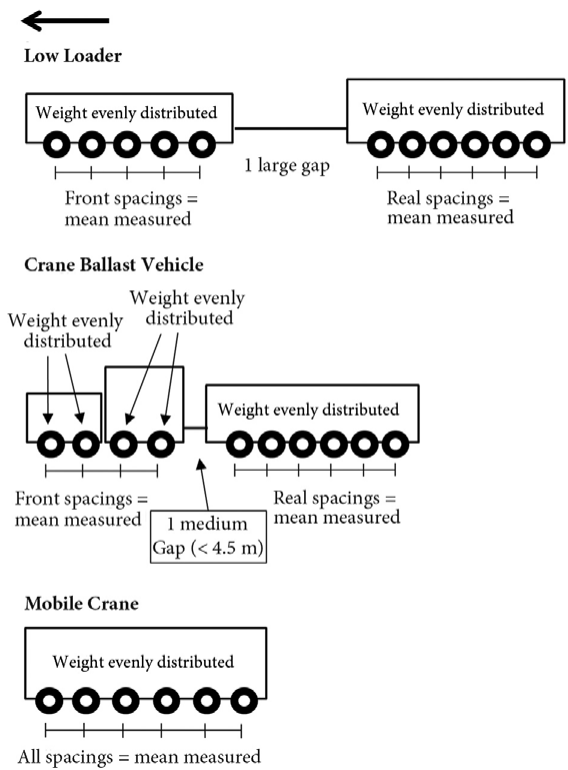
Fig. 4. Simplified vehicles used in simulation to represent the three permit truck types found in Poland WIM data (Enright et al. 2 015)